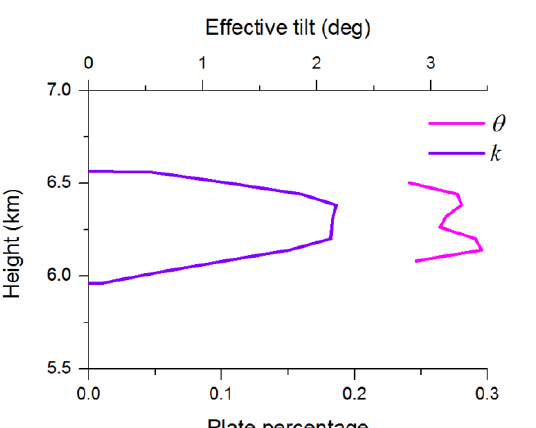
Figure 4. Case 2: Depolarization ratio